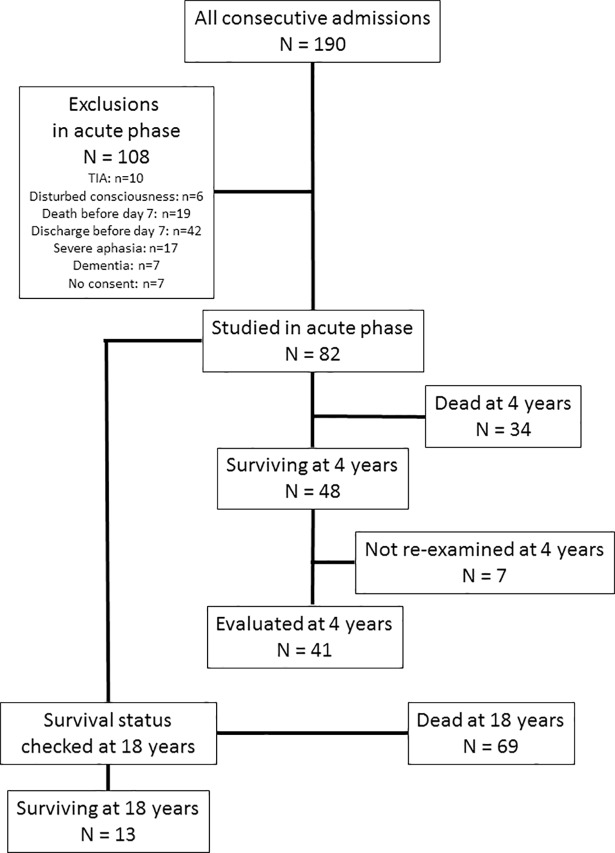
Patient flowchart.